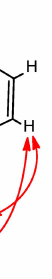
Figure 5. Key NOE correlations in Ochraceopyronide ( 1 ).